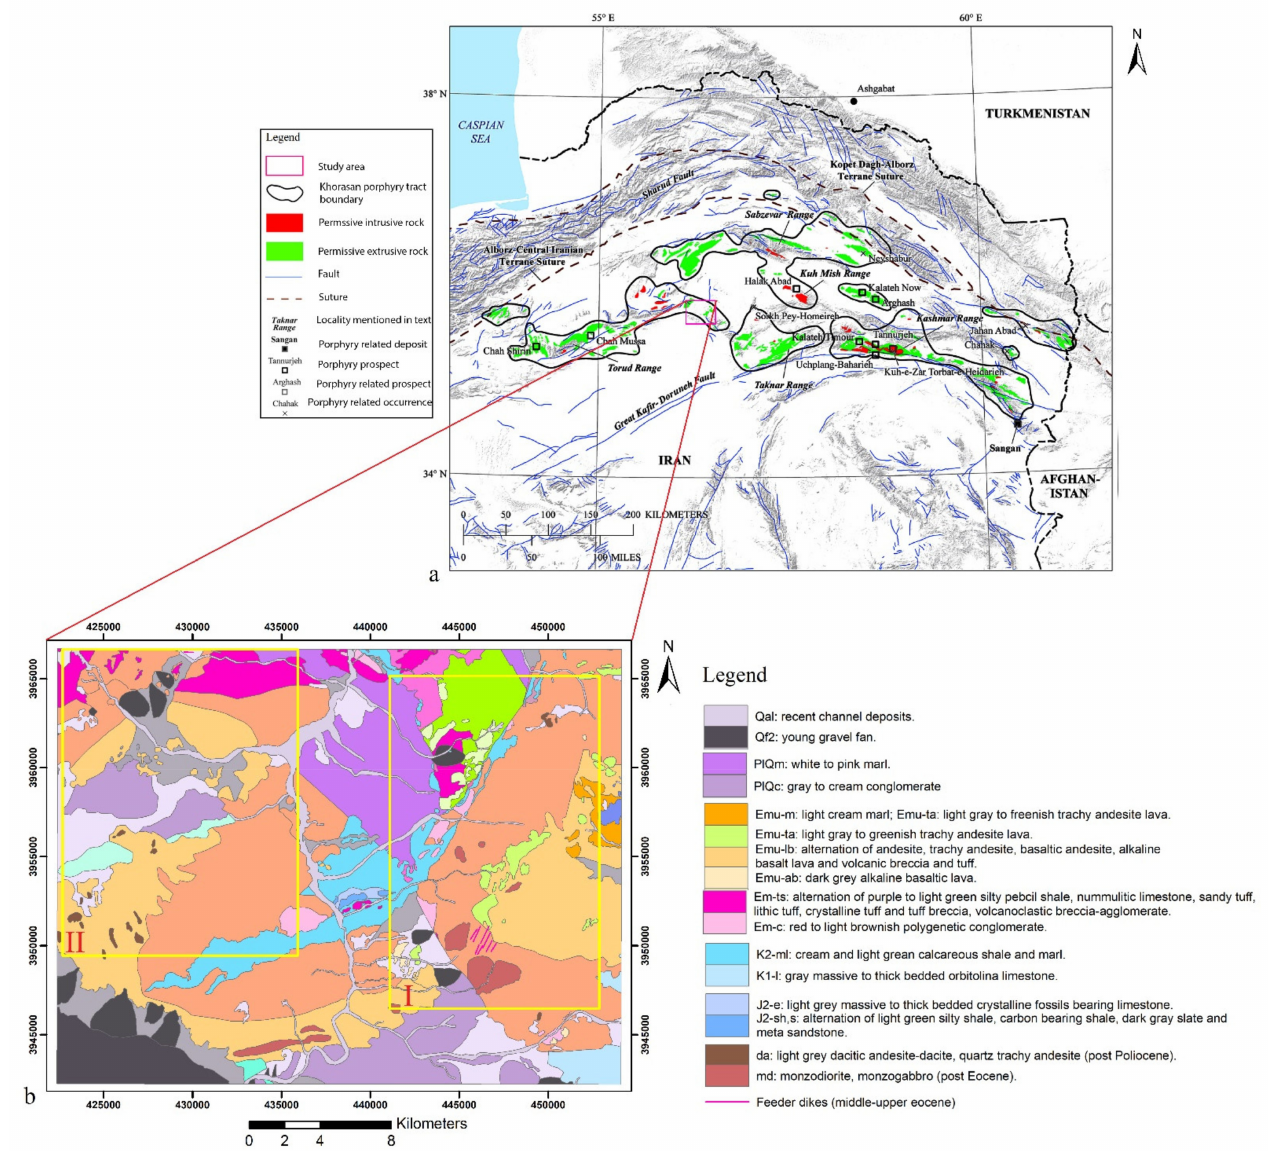
Figure 1. ( a ) Location of the study area in Troud Range (modified after Reference [54]); ( b ) lithological map of the study area (modified after Reference